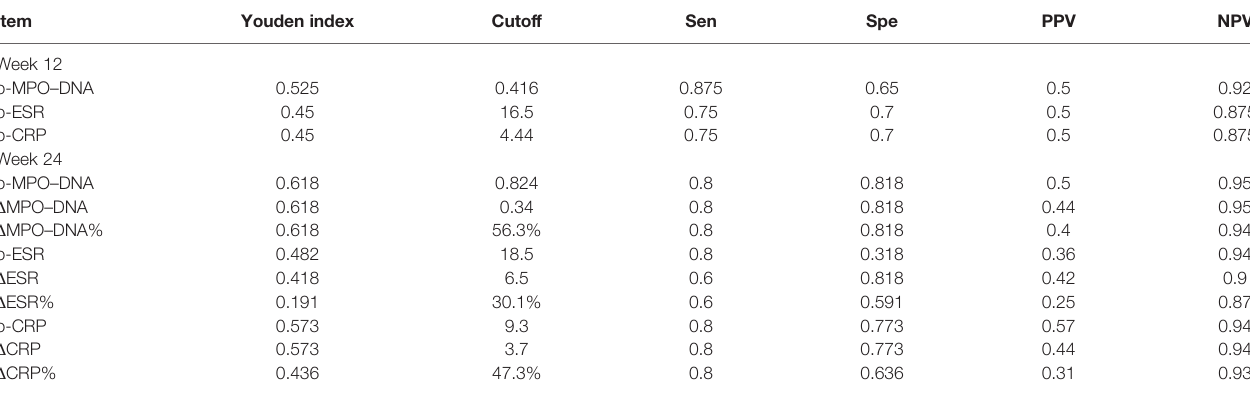
Item Youden index Cutoff Sen Spe PPV NPV